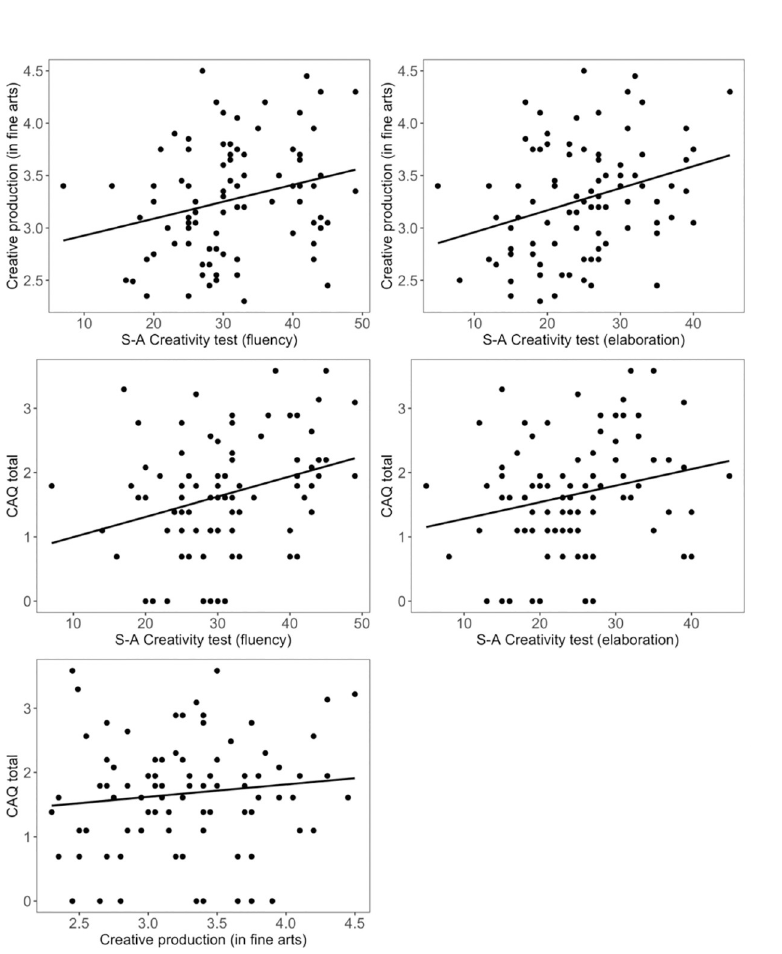
Fig 4. Results of correlational analysis among creativity